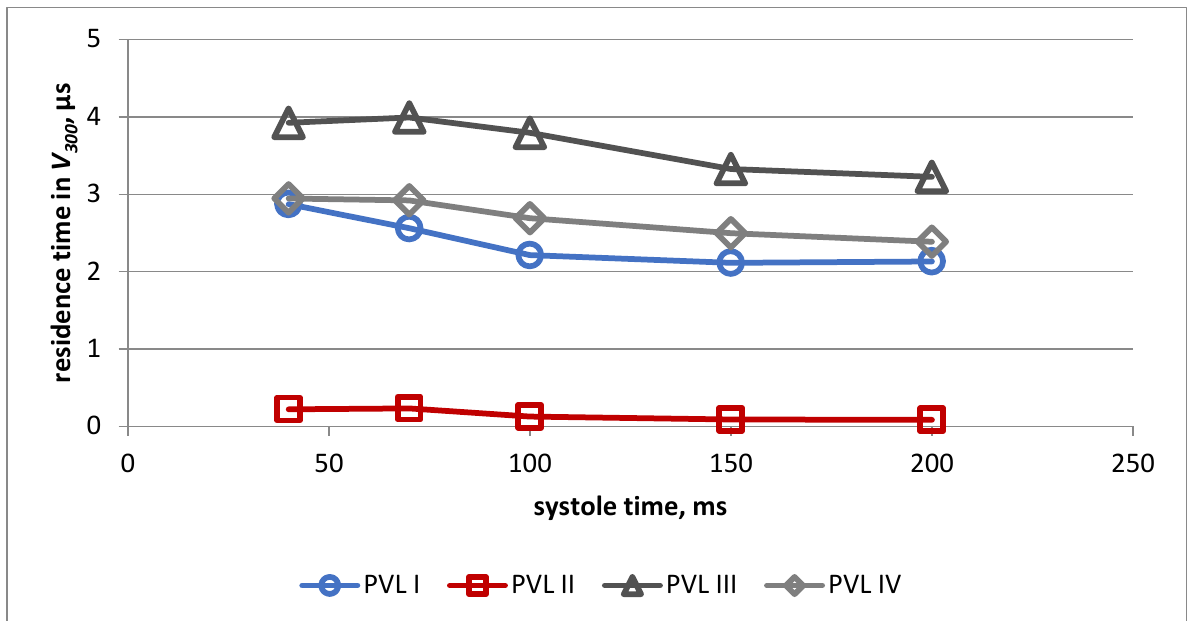
Figure 11. Duration of exposure to shear stress > 300 Pa during systole for all PVL models. Table 3. LDH levels in subjects with respective PVLs. LDH levels for each subject are presented in Table